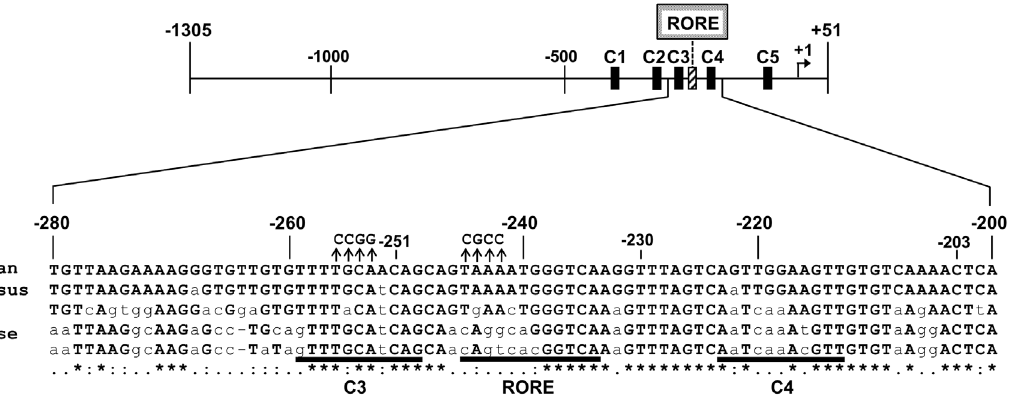
Fig 1. ROR α and C/EBP binding sites in PEPCK. Schematic representation of ROR α and C/EBP binding sites (RORE, C1, C2, C3, C4, and C5) in human PEPCK. The nucleic acid sequence is shown, with binding sites underlined and conserved sequences marked with asterisks. Mutations used in luciferase reporters are indicated with arrowheads. ROR α and C/EBP β regulate gene expression, mainly by binding their respective response